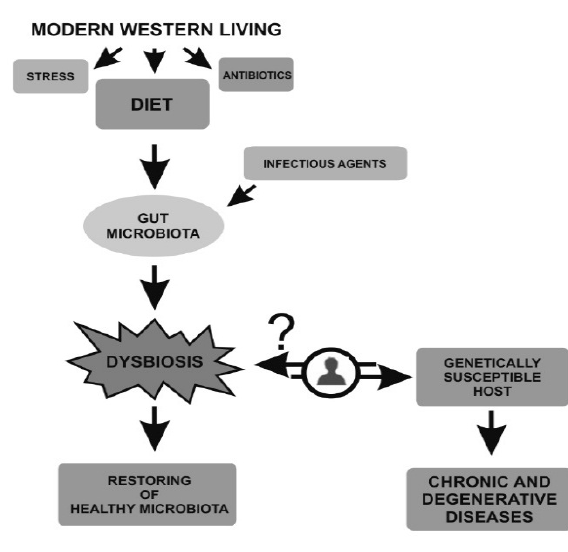
Figure 1. Triggering factors